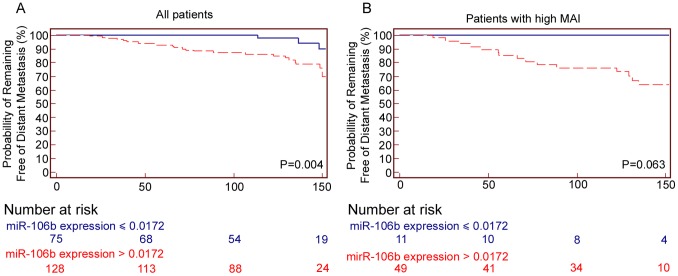
Long-term distant metastasis free survival curves according to miR-106b expression level and miR-106b expression in patients with MAI≥10.